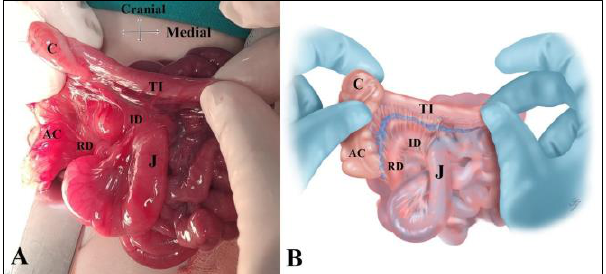
Figure 2: Intestinal anatomy after further releasing the bonds